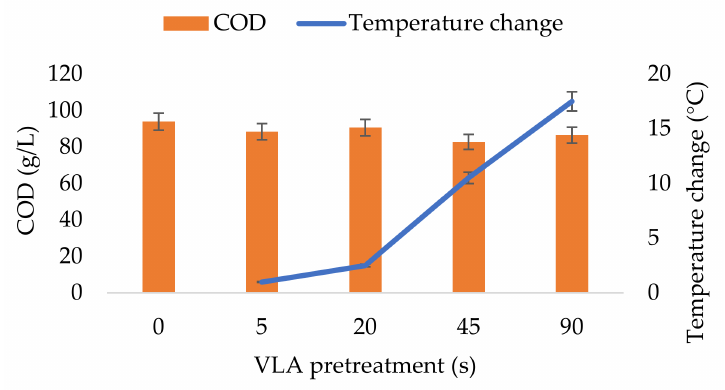
Figure 1. Change in COD and temperature of CW after pretreatment in